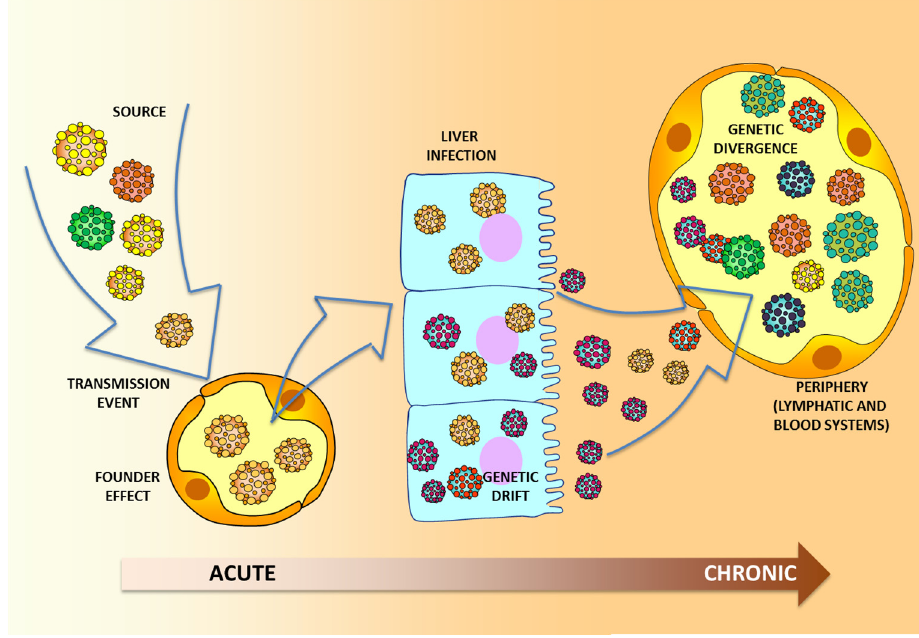
Figure 4. HCV intrahost molecular evolution. The main forces driving the molecular evolution of HCV are depicted. The generation of viral diversity during the course of natural infection is illustrated. Upon infection, the virus migrates via blood vessels to the liver where replication takes place. Viral diversity is increased throughout the infection process and reflected in the periphery over time.